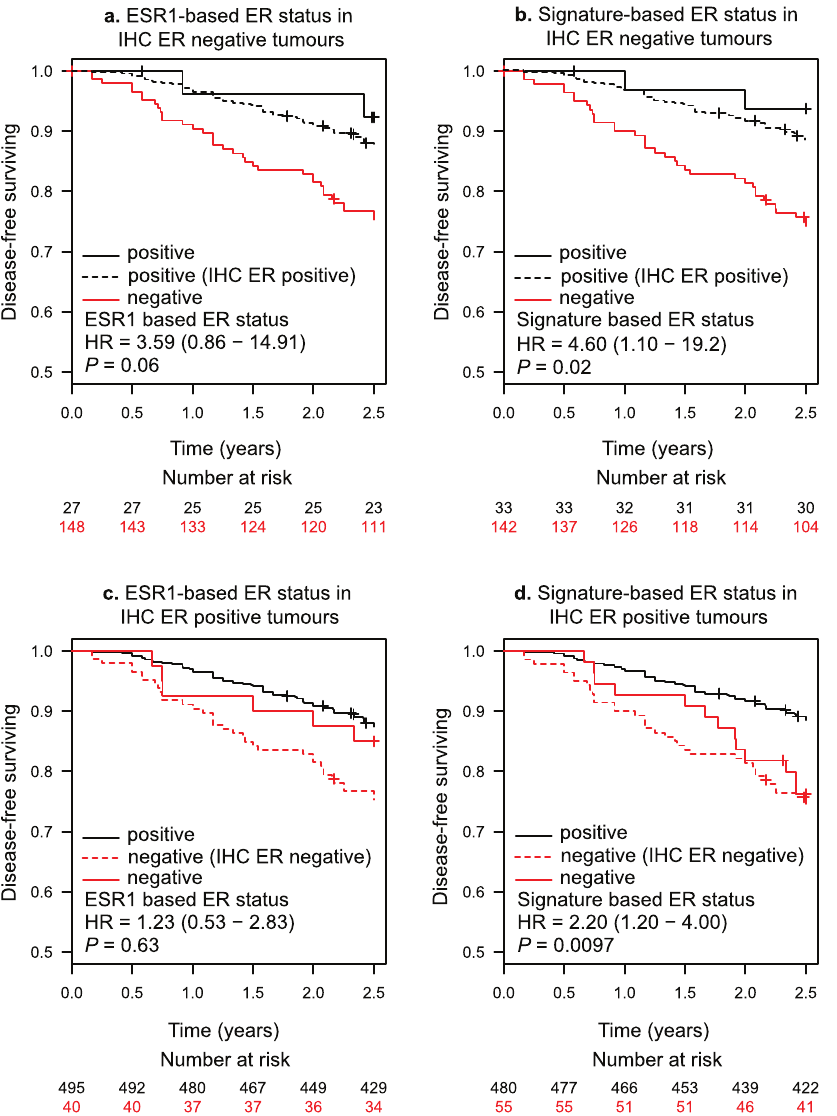
Figure 3. Expression-based ER classifiers reveal misclassification of IHC-based ER status which associated with clinical outcome. KM curves of disease-free survival showing IHC based ER- tumours separated by (a.) ESR1 expression-based and (b) 23-gene signature-based ER status; false ER- (23-gene signature based ER + , IHC based ER-) showed significantly better outcome which is close to true ER + (23-gene signature based ER + , IHC based ER + , black dashed-line). And IHC based ER- tumours are separated by (c.) ESR1 expression and (d.) 23-gene signature based ER status; false ER + (23-gene based ER-, IHC based ER + ) showed significantly worse outcome which is close to true ER- (23-gene signature based ER-, IHC based ER-, red dashed-line).